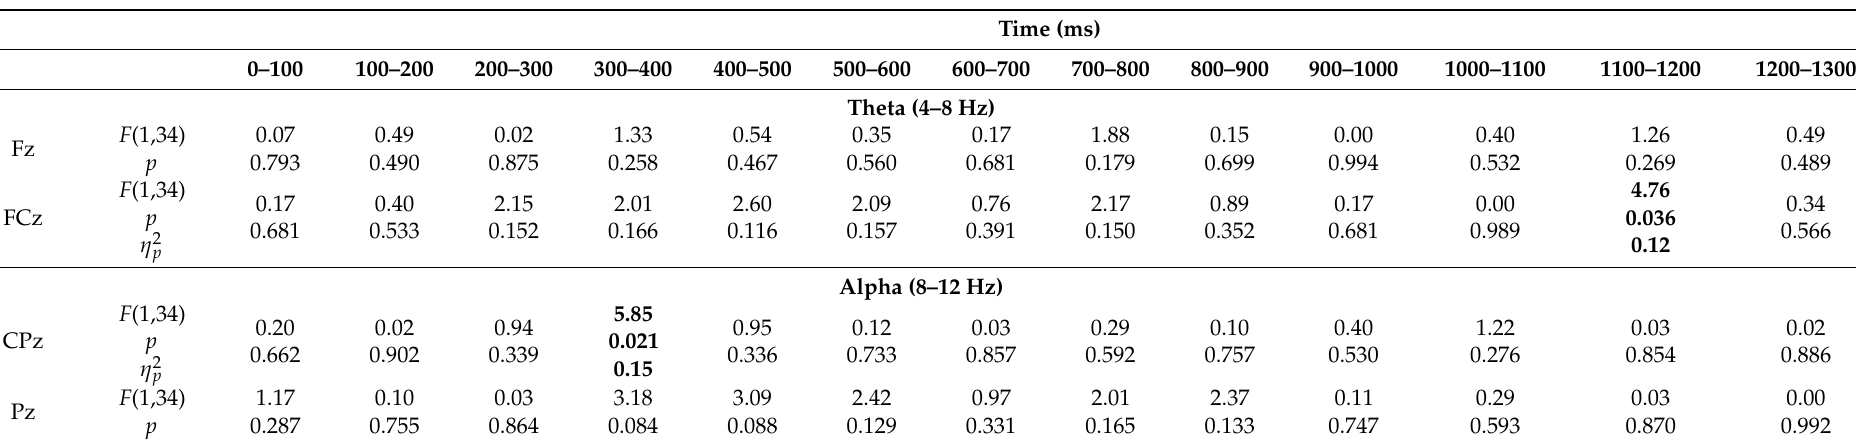
Table 5. Statistical Results for Group-by-Value Interactions for Theta and Alpha Band Mean